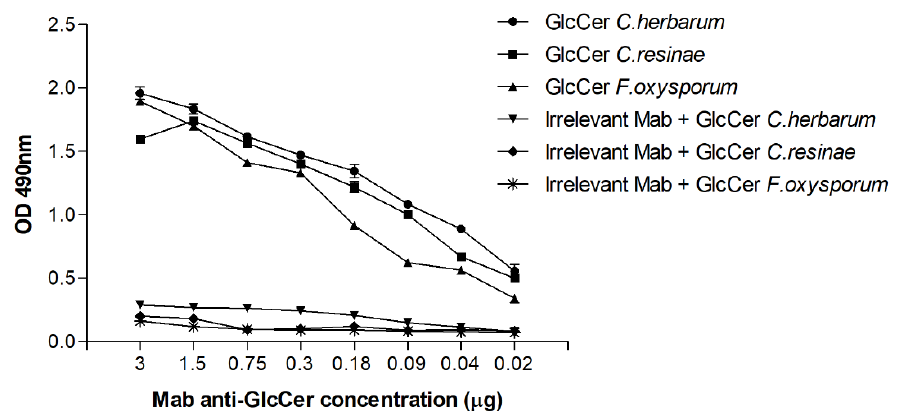
Figure 4. Reactivity of anti-GlcCer Mab with GlcCer from Cladosporium species, measured by ELISA. F. oxysporum GlcCer was used as positive control and irrelevant IgG Mab was used as negative control. The ELISA was performed in triplicate.